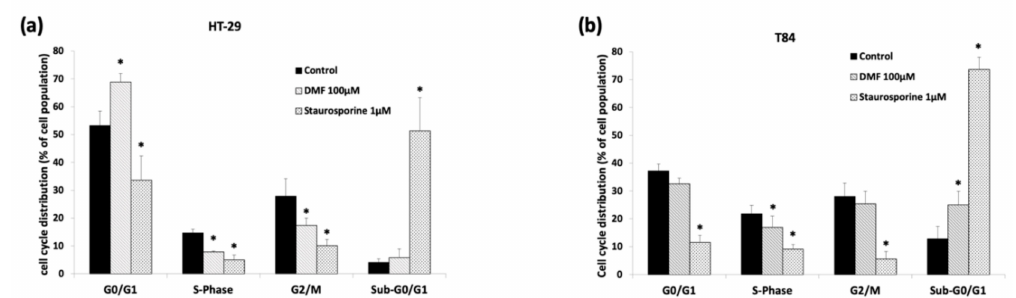
Figure 3. DMF induces G0 / G1 arrest in HT-29 and increases the sub-G0 / G1 phase in T84. Analysis of cell cycle distribution by FACS using propidium iodide-stained colon carcinoma cell lines ( a ) HT-29 treated with 100 µ M DMF for 24 h; ( b ) T84 were treated with 100 µ M DMF for 24 h. Positive control: Staurosporine 1 µ M; Negative control: DMSO 0.2%. Data displayed are the mean values of at least three independent experiments and results are shown as mean ± SD. * p < 0.05: